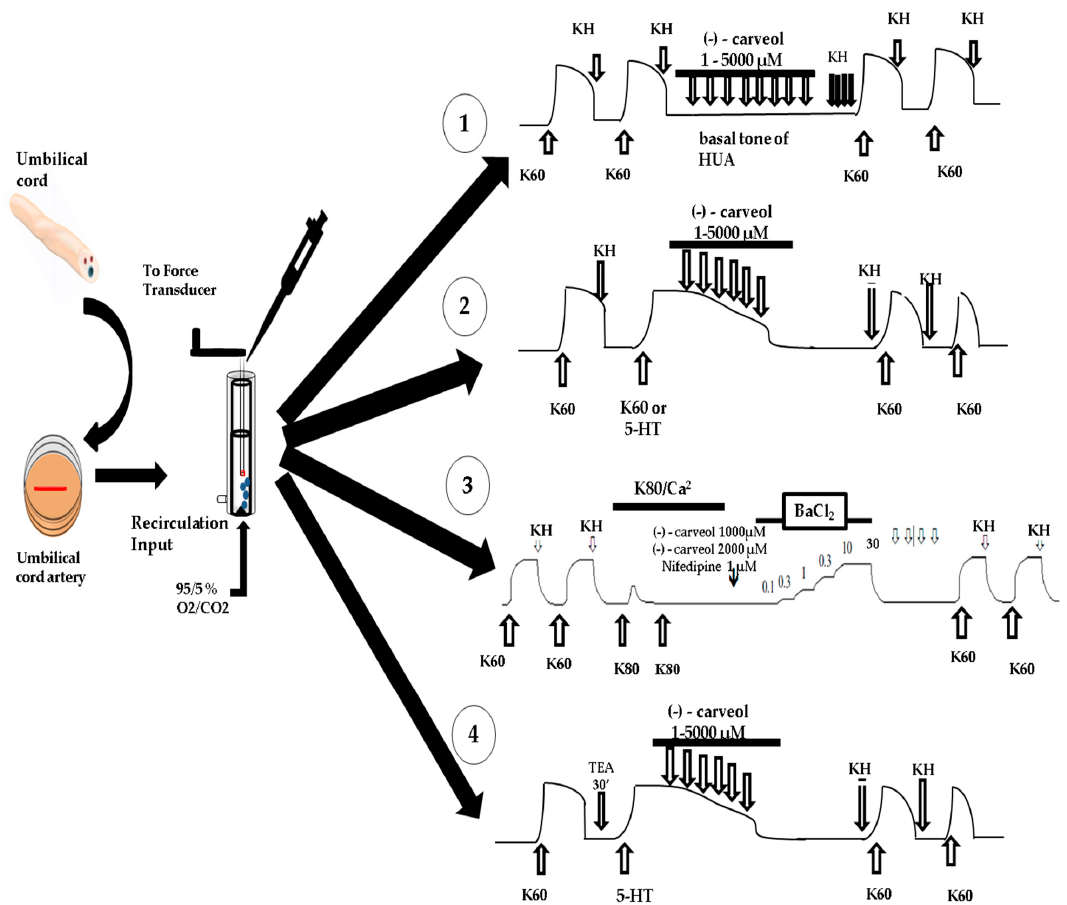
Figure 1. Illustrative scheme of experimental protocols. (1) Schematic representation of the e ff ect of ( − )-carveol on the basal tone of the HUA. (2) Schematic representation of the e ff ect of ( − )-carveol on contractions sustained by K60 or 5-HT. (3) Schematic representation of the e ff ect of ( − )-carveol on BaCl 2 contractions in the presence of K80 without Ca +2 . (4) Schematic representation of the e ff ect of ( − )-carveol on sustained contractions induced by 5-HT in the presence of potassium channel blockers (tetraethylammonium—TEA). (* KH = Krebs–Henseleit solution).